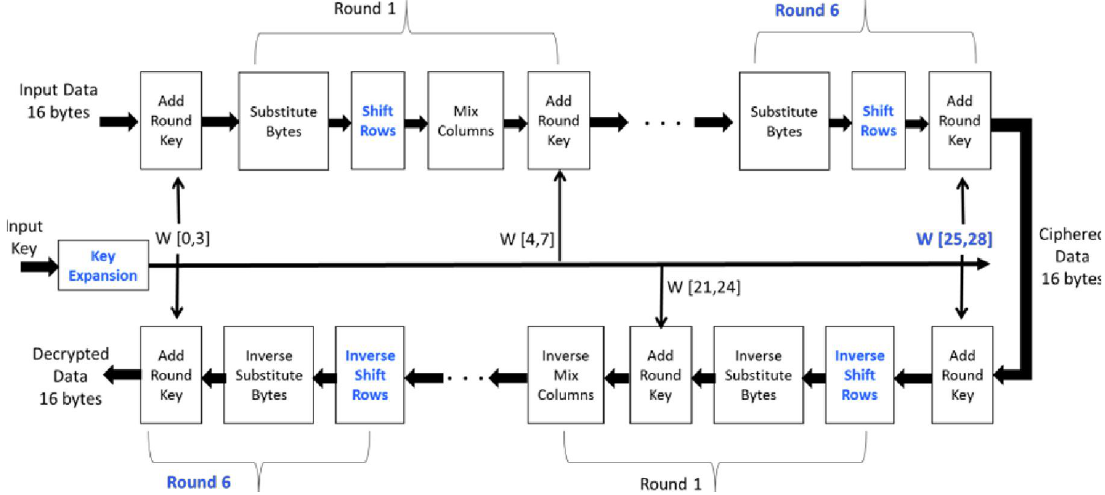
FIG. 2. BLOCK DIAGRAM OF CR-AES (NEW CONTRIBUTIONS HIGHLIGHTED IN